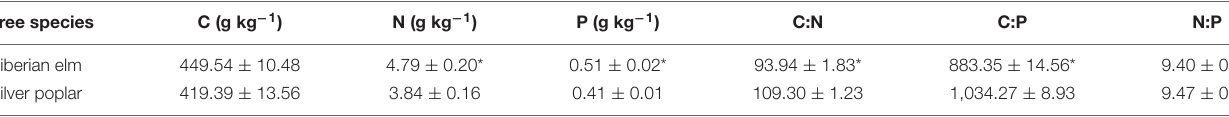
TABLE 2 | The C, N, and P concentrations and their ratios in leaf litter of elm and poplar plantations. Tree species